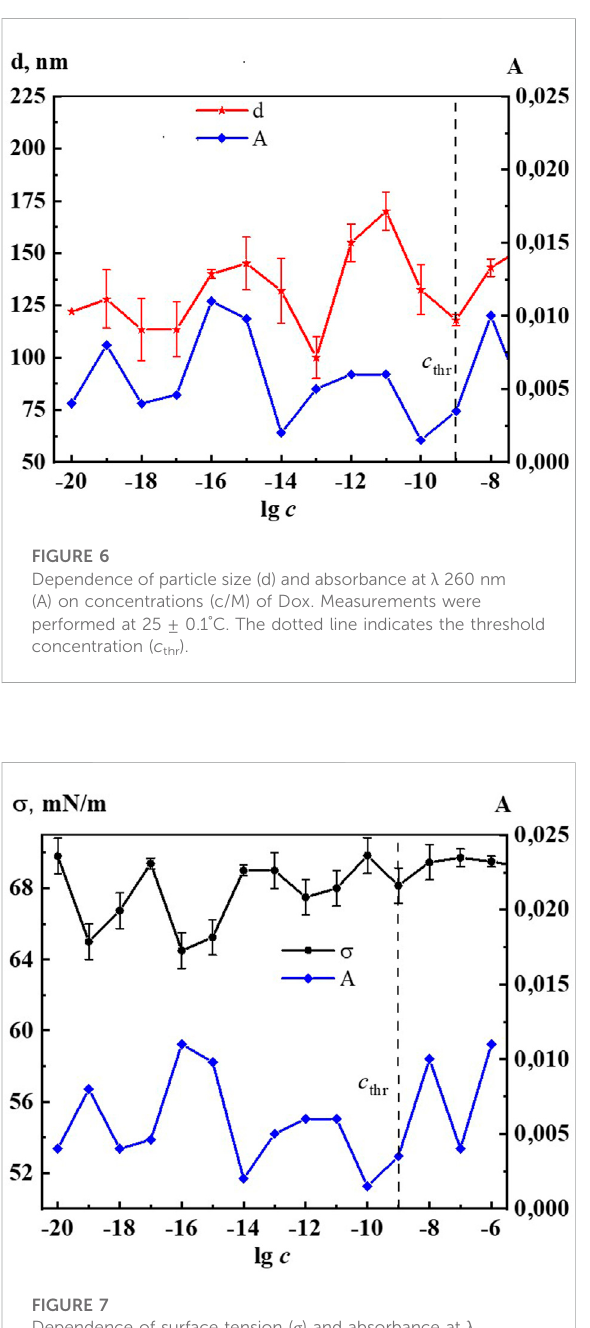
FIGURE 7 Dependence of surface tension ( σ ) and absorbance at λ 260 nm (A) on concentrations (c/M) of Dox. Measurements were performed at 25 ± 0.1 ° C. The dotted line indicates the threshold concentration ( c thr ).